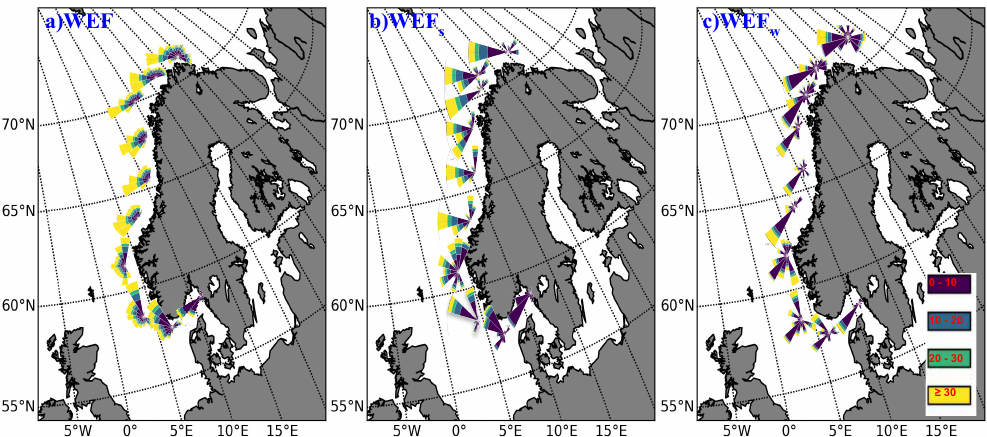
Figure 10. Roses of ( a ) total as well as ( b ) swell- and ( c ) wind-sea-induced WEF along the Norwegian coast. The colors illustrate the WEF intervals, purple: from 0 to 10 kW m − 1 ; light blue: from 10 to 20 kW m − 1 ; cyan: from 20 to 30 kW m − 1 ; yellow: greater than 30 kW m − 1